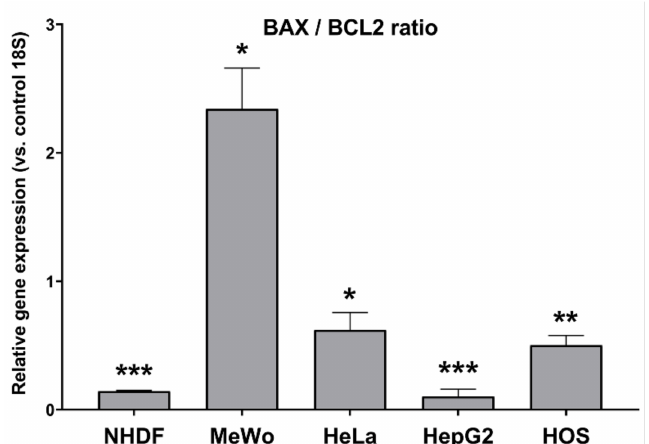
Figure 9. BAX/BCL2 gene expression ratio in normal dermal fibroblasts (NHDF), malignant melanoma (MeWo), adenocarcinoma (HeLa), hepatocellular carcinoma (HepG2) and osteosarcoma (HOS) cells treated with cell line-specific IC 50 of CBD-enriched hemp oil for 48 h. Control cells were incubated with complete cell culture medium. Experiments were done in triplicate, obtained data were expressed as mean 2 − ∆∆ Cq values (vs. 18S of control cells) ± standard error of the mean. * p < 0.05, ** p < 0.01, *** p < 0.001 vs. control cells (NHDF p < 0.0001, MeWo p = 0.013391, HeLa p = 0.049447, HepG2 p = 0.000092, HOS p =